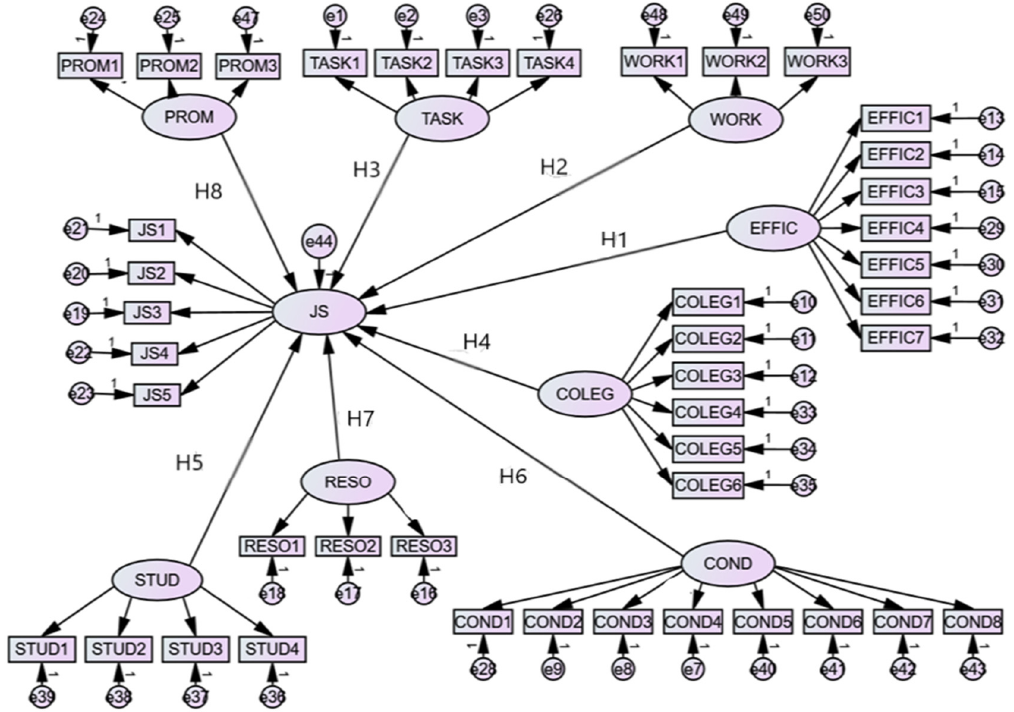
Figure 1. Proposed research model for the study.